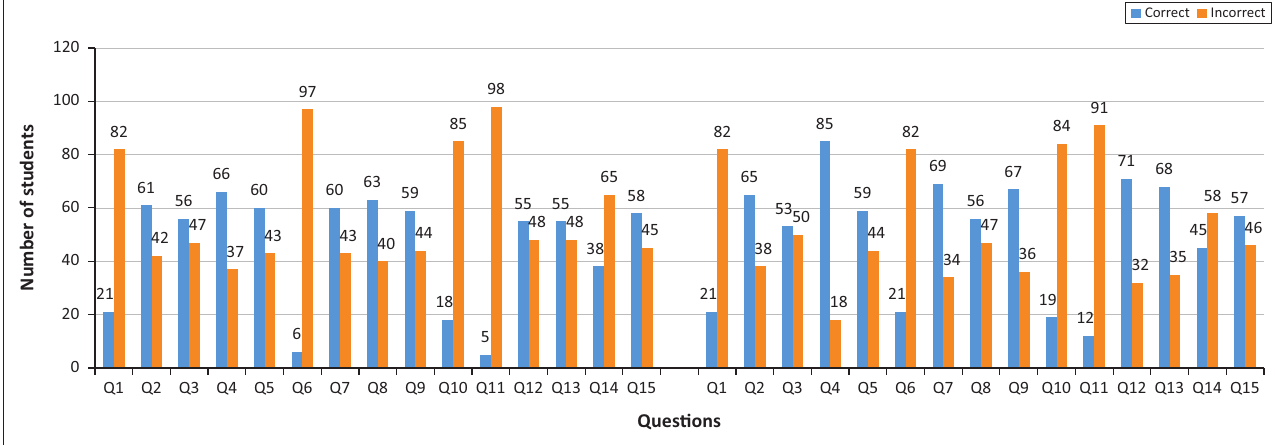
FIGURE 3 : Pre- and post-test results by questions.